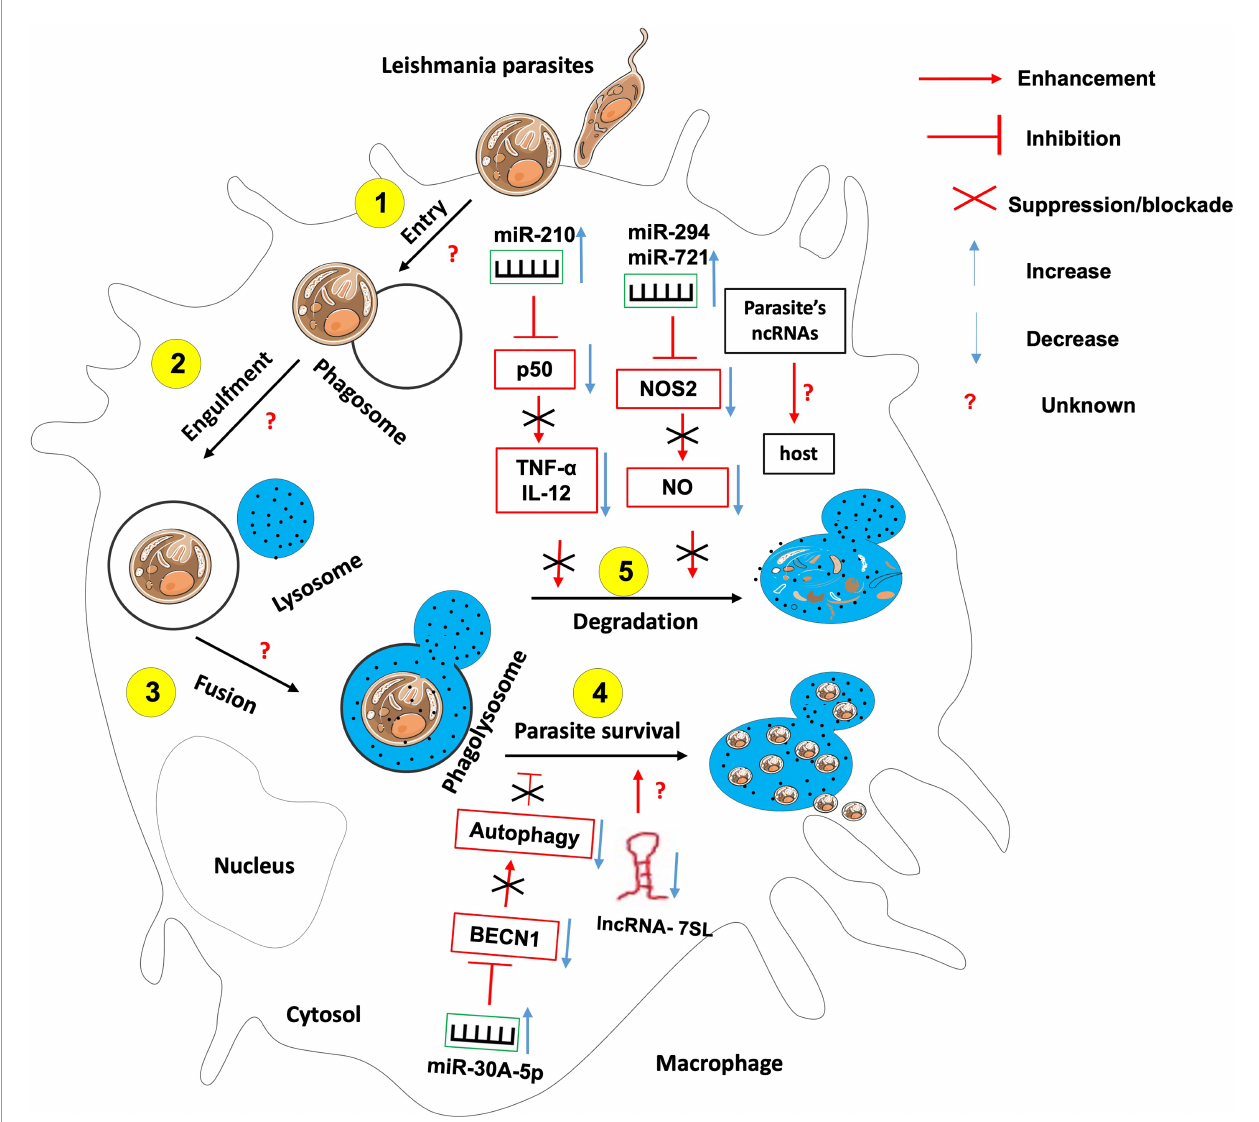
FIGURE 4 | The role of non-coding RNAs in the etiology of leishmaniasis. Most studies have identi fi ed ncRNAs that enhance host effector killing functions against leishmania parasites as well as those that favor parasite survival and persistence within the infected host. There is knowledge gap about 1- host ncRNAs that regulate the parasite entry within the host, its engulfment within phagosome and the fusion between phagosome and lysosomes; 2- the role of Leishmania-derived ncRNAs on the outcome of leishmania-macrophage